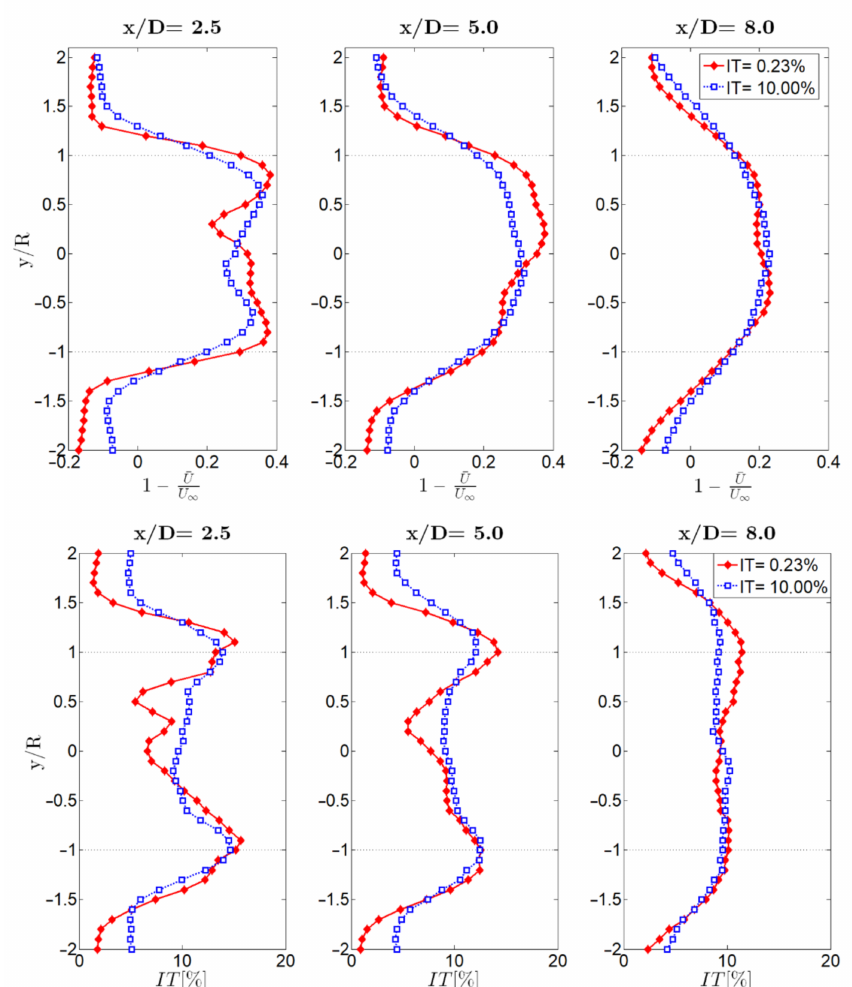
Figure 10. Velocity deficit ( top ) and turbulence intensity ( bottom ) in the horizontal plane downstream T1 for x/D = 2.5, 5.0 and 8.0. λ _T1 = 6.0. High turbulence intensity inflow marked blue, low marked red.